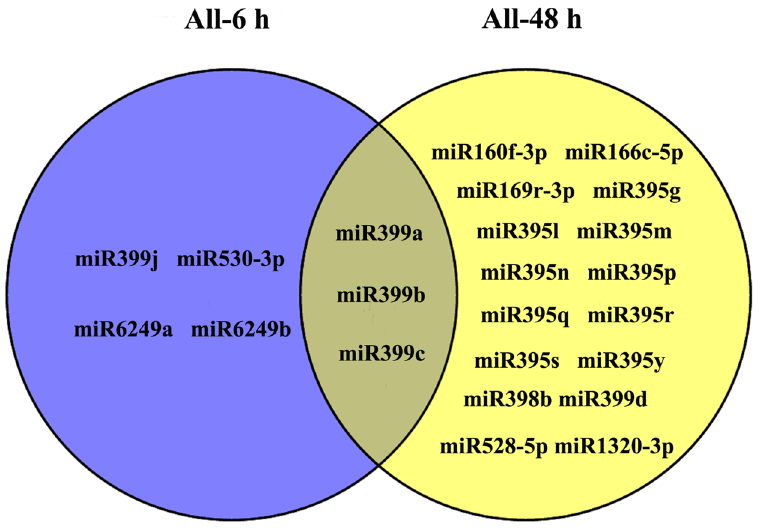
Figure 7. Venn diagram of common defense-related miRNAs in two rice genotypes 6 h and 48 h after BPH feeding.